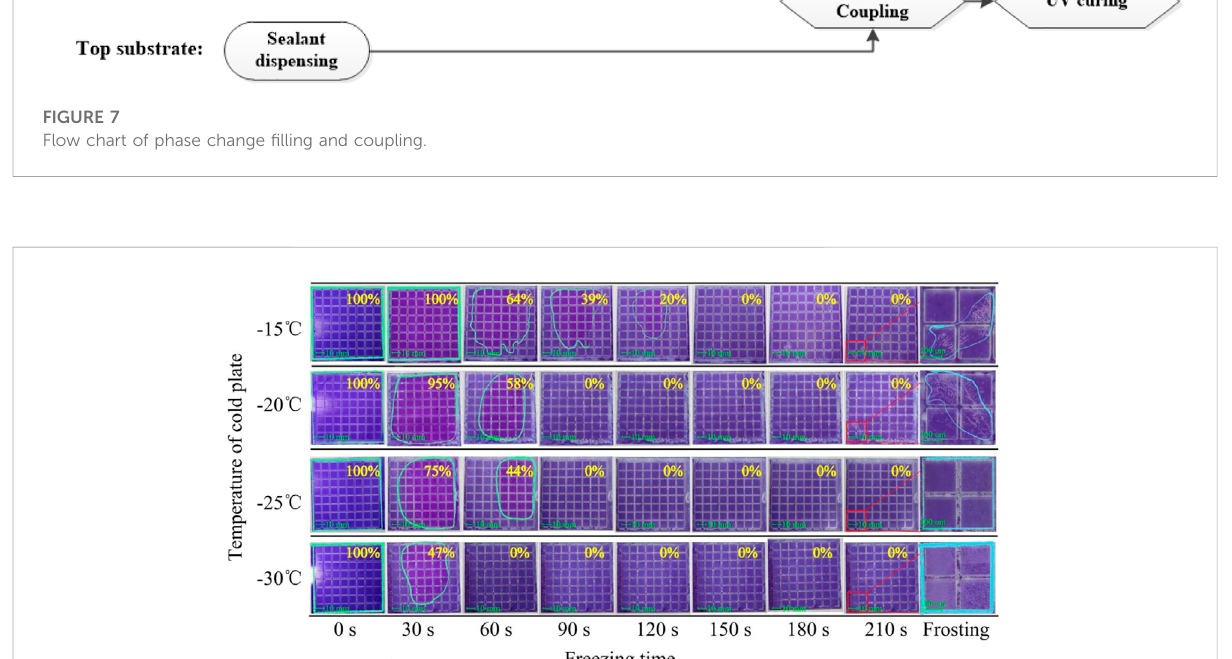
FIGURE 8 Proportions of unphase-changed oil at different temperatures and freezing